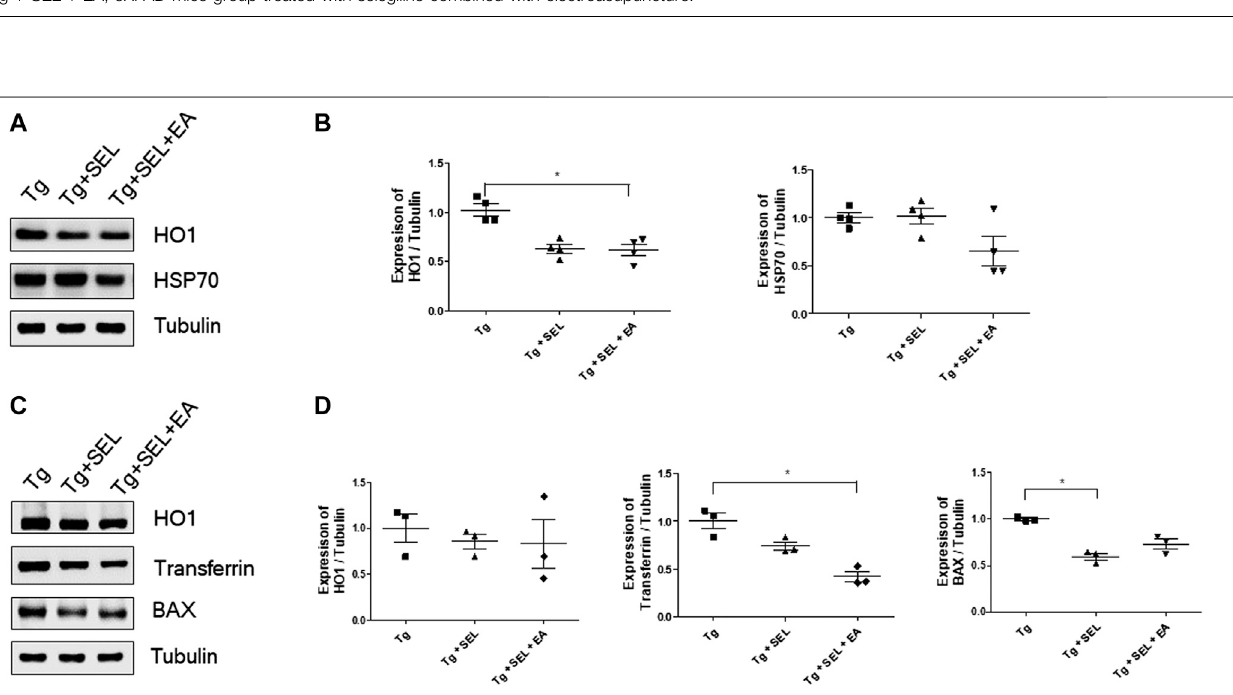
FIGURE 4 | Means ± SEM for the expression of HO-1, transferrin, BAX, and HSP70 for Tg, Tg + SEL, and Tg + SEL + EA mice groups. (A) Representative immunoblot images from the hippocampi. (B) Quanti fi cation of expression levels in the hippocampi (n (cid:2) 4/group). (C) Representative the immune blot images also including HO1, transferrin, and BAX from the prefrontal cortex. (D) Quanti fi cation of expression levels in the prefrontal cortex (n (cid:2) 3/group). Statistical analysis of the immune blot was analyzed using Kruskal – Wallis test and Dunn ’ s multiple comparison test with p values < 0.05 considered statistically signi fi cant. SEM, standard error of mean; Tg, 5XFAD mice group; Tg + SEL, selegiline-treated 5XFAD mice group; Tg + SEL + EA, 5XFAD mice group treated with selegiline combined with electroacupuncture.